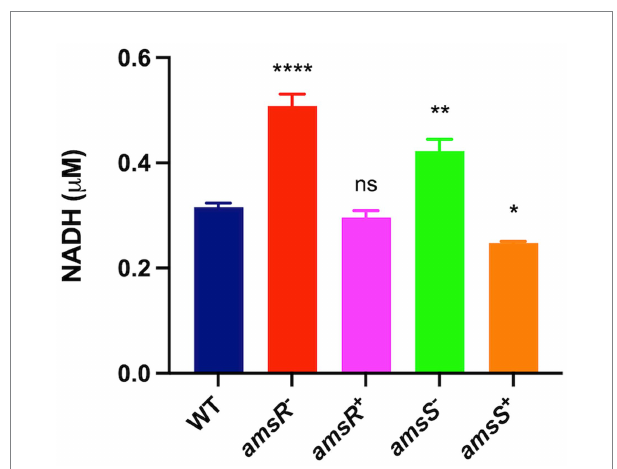
FIGURE 9 Disruption of AmsSR results in elevated intracellular NADH